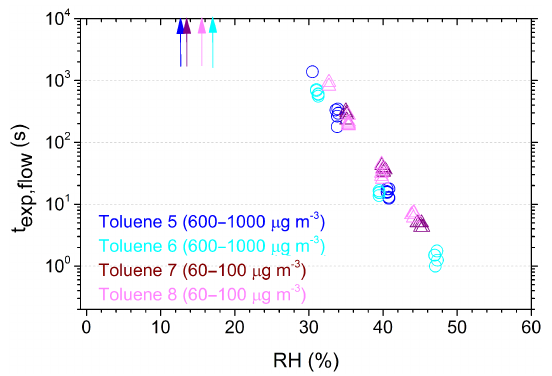
Figure 3. Measured average bead speeds as a function of RH for different SOM samples (toluene 1, 2, 3, and 4, see Table 1). The bead speeds of 3–10 beads were used to determine a mean bead speed. The x error bars represent the uncertainty in the RH mea- surements and the range of RH values in a given experiment. The y error bars represent the standard deviation of the measured bead speeds.